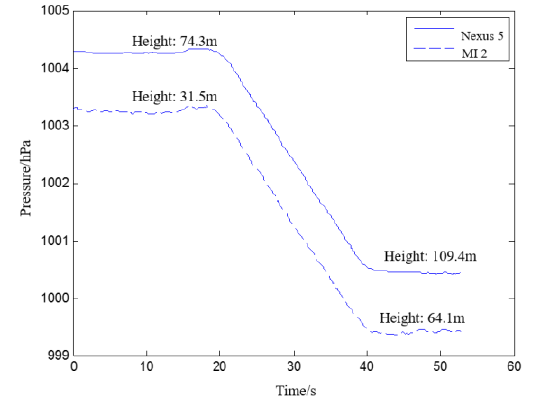
Figure 3. The pressure changes of different devices during taking elevator How to select appropriate time interval τ and upper value 𝑇ℎ 𝑢𝑝 and lower value 𝑇ℎ 𝑑𝑜𝑤𝑛 of pressure difference will impact the detecting results